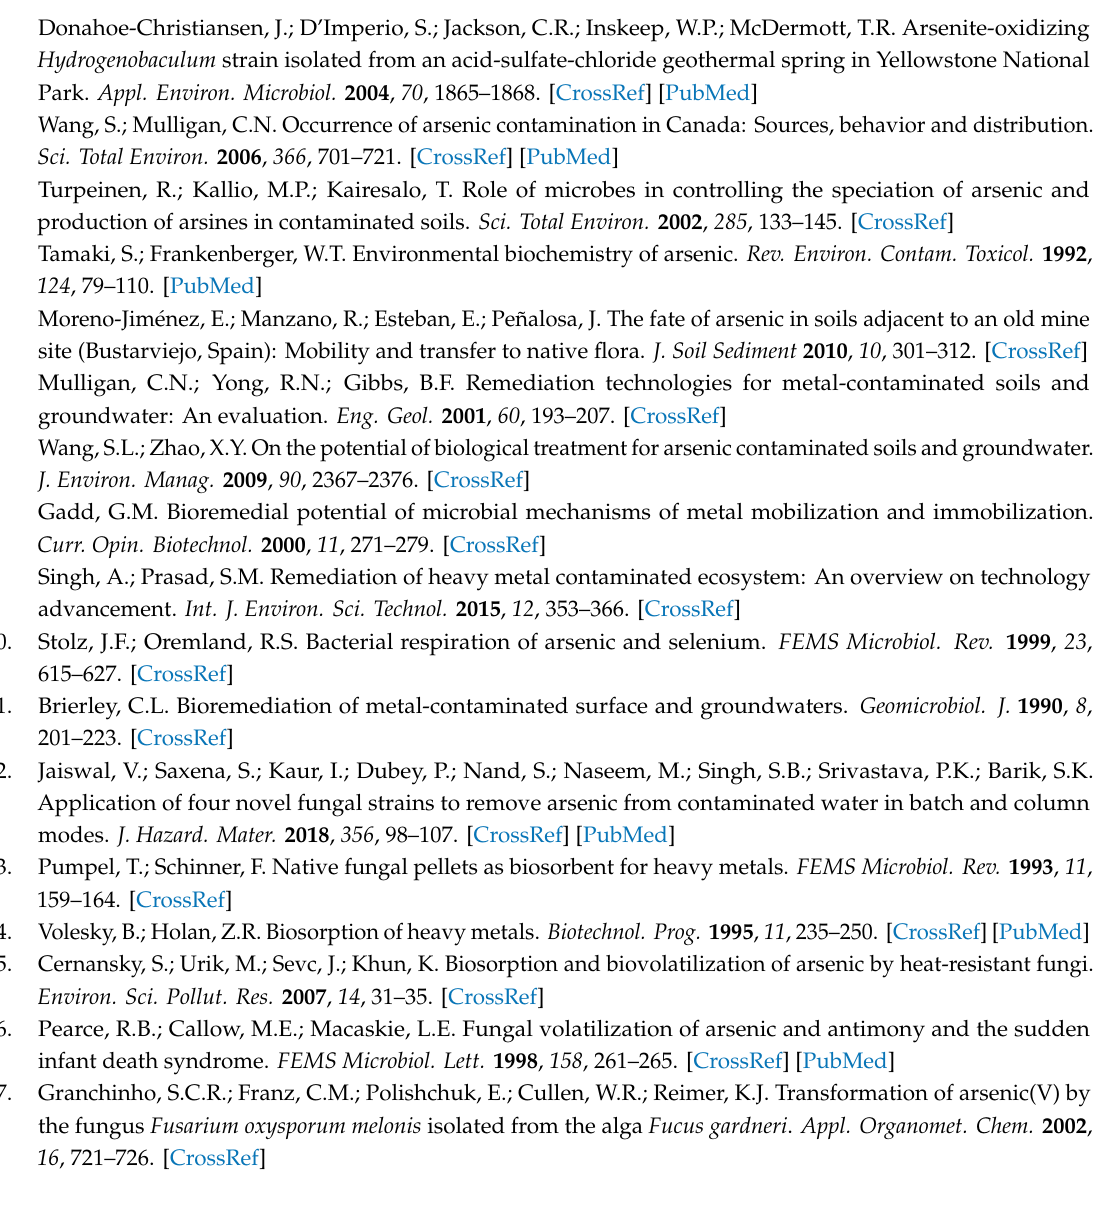
Table S1: Growth of Talaromyces sp. KM-31 in PDA medium amended with As(III) or As(V).; Table S2: Arsenic removal (%) by Fe(III) oxides as a non-fungal